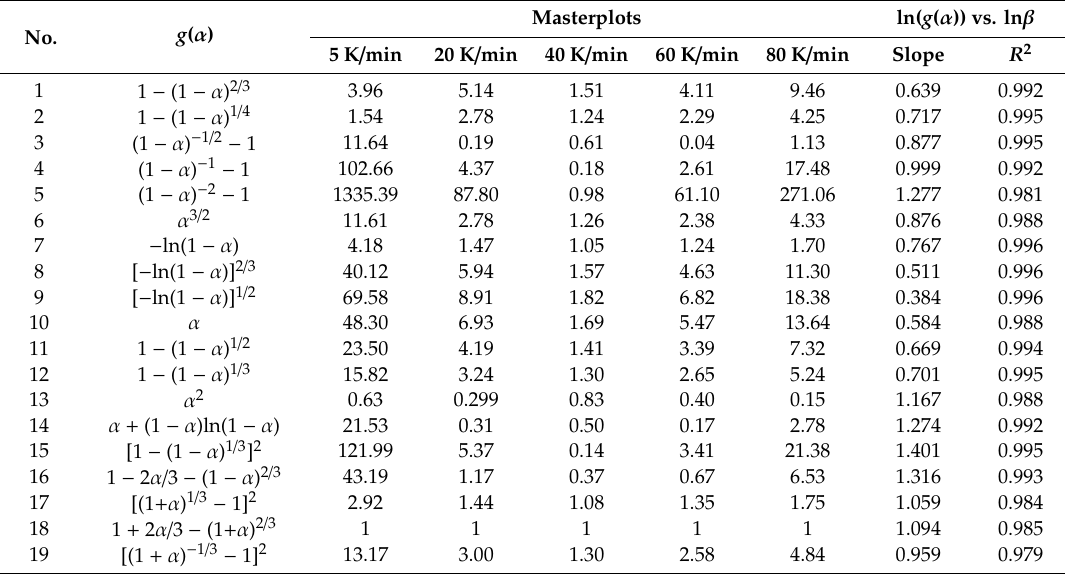
Table 4. Reaction mechanisms are determined by masterplots and the iterative procedure methods. No.